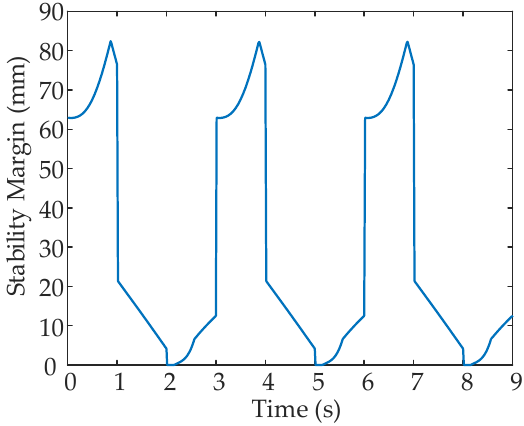
Figure 22. Stability margin variation with leg 2 fault.